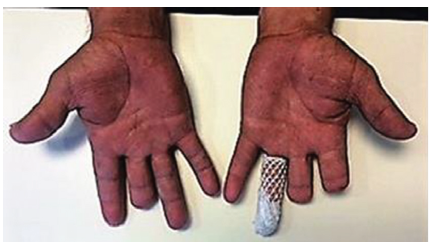
Figure 2: Resolution of necrotic lesions after 3 cycles of ABVD protocol (3 months from the HL diagnosis). Amputation of three phalanges was